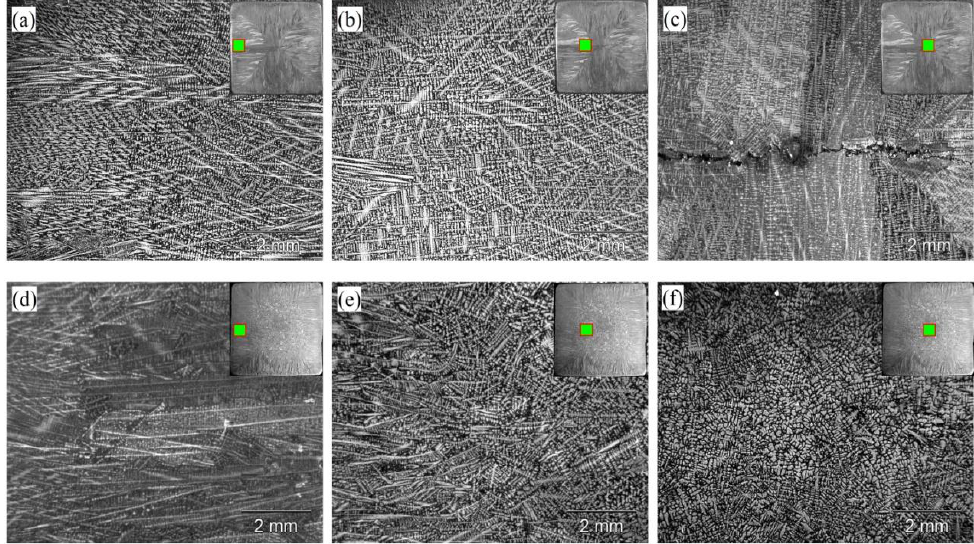
Figure 4. Microstructure of the billet: ( a – c) represent the location of edge, 1/4 width and 1/2 width of the specimen obtained from Set I, respectively; ( d – f ) represent the location of edge, 1/4 width and 1/2 width of the specimen obtained from Set II, respectively.